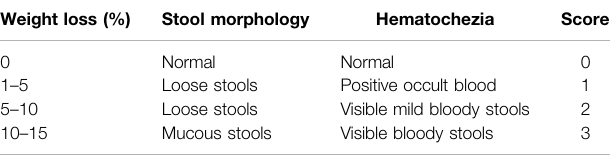
TABLE 1 | DAI scoring standards of UC